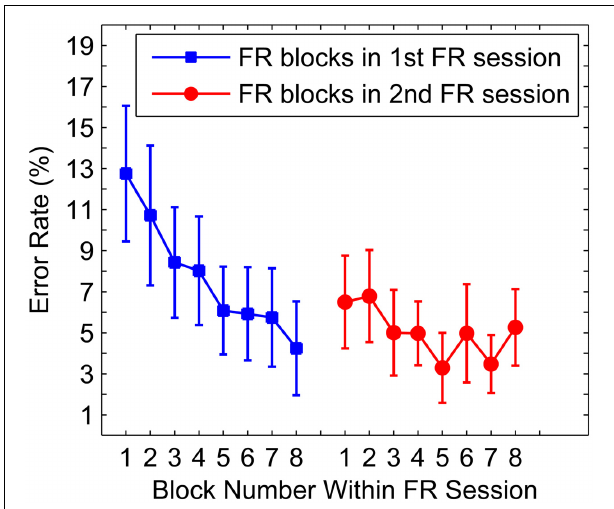
FIGURE 6 | Mean error rate as a function of FR block. Mean error rates per FR block in the first two sessions (i.e., FR sessions). Blue squares correspond to FR blocks in the first FR session and red circles correspond to FR blocks in the second FR session. Error bars denote the standard error of the